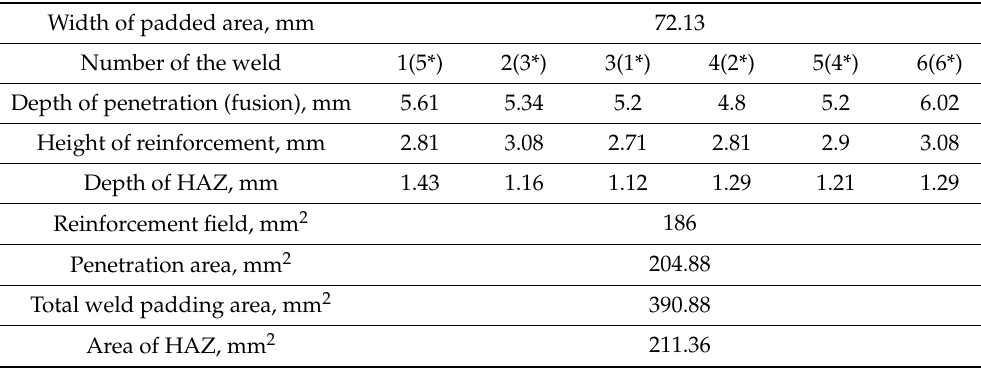
Table 2. The geometrical characteristics of the deposition zone in plate B.